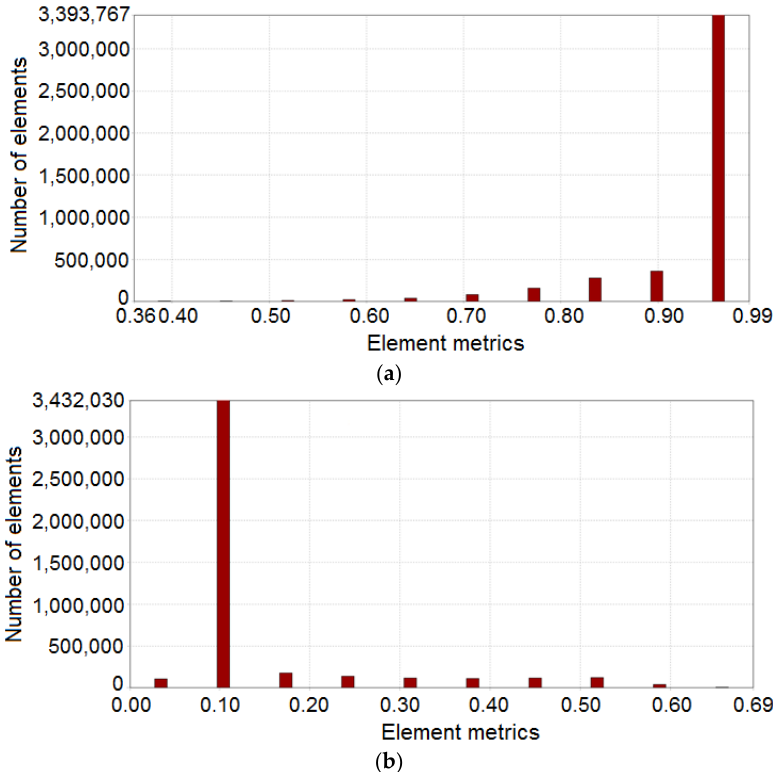
Figure 6. Mesh metrics obtained in the absence of bumps. ( a ) Orthogonal quality ( b ) Skewness.